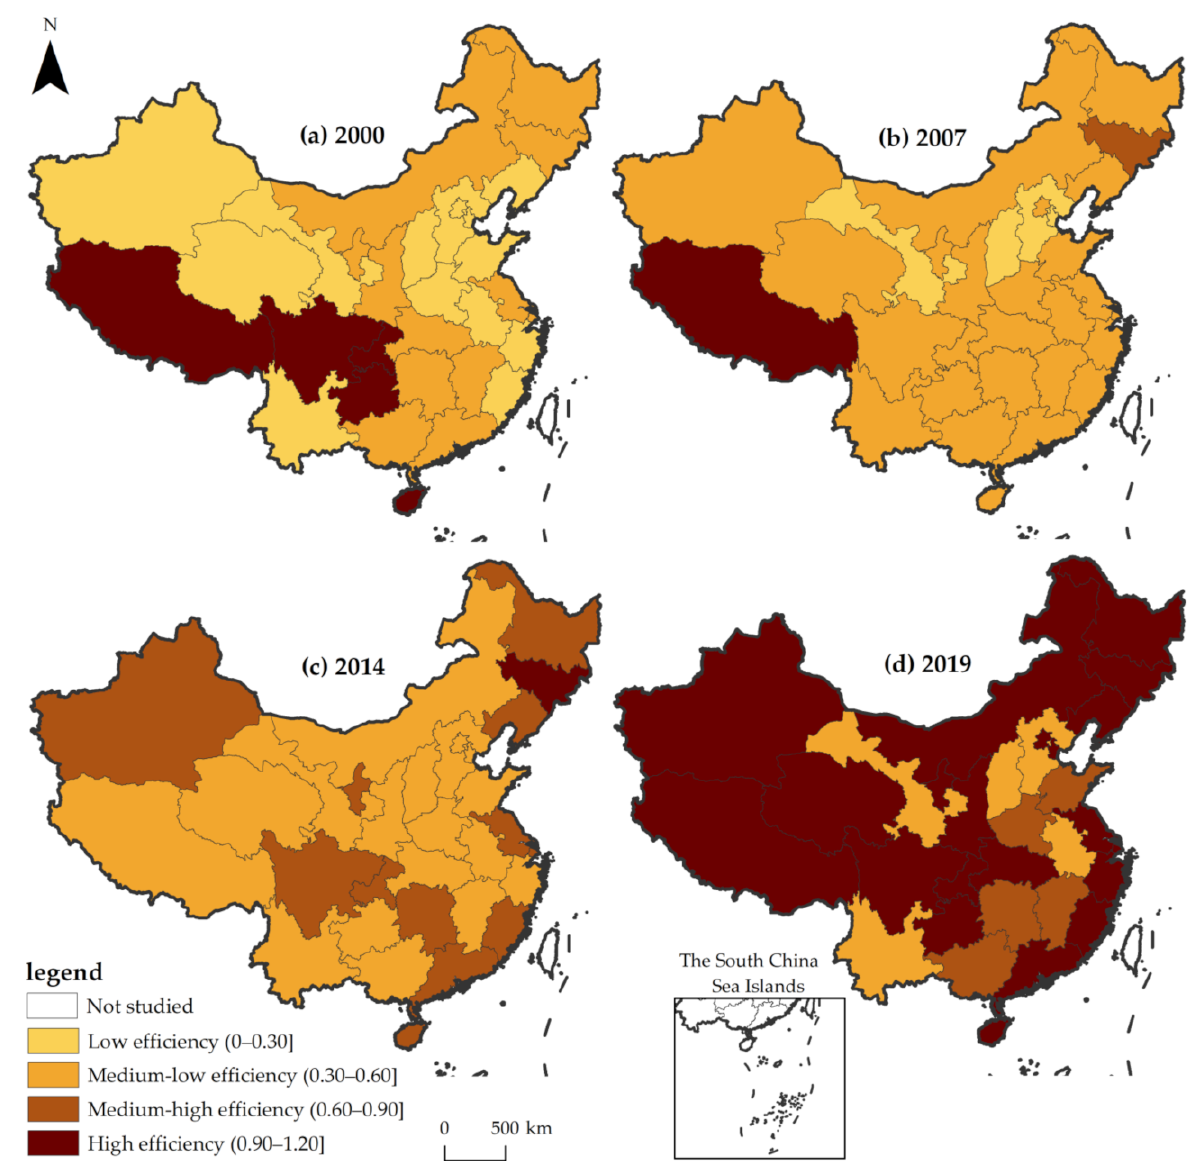
Figure 3. Spatial distribution of EALU in China. ( a ) The year of 2000; ( b ) The year of 2007; ( c ) The year of 2014; ( d ) The year of